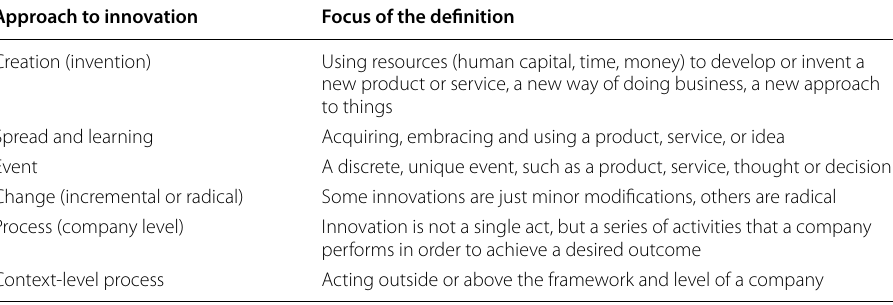
Source: Ahmed and Shepherd